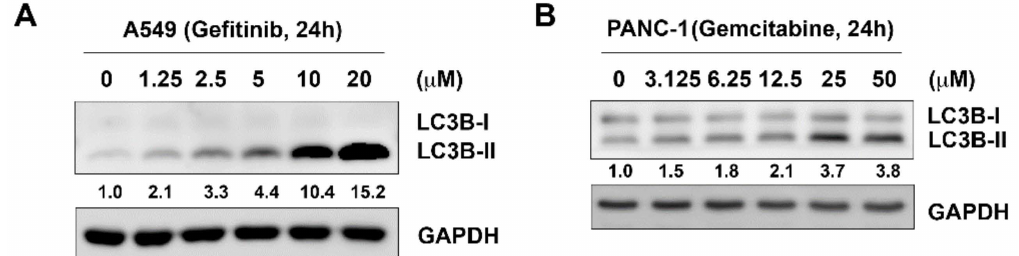
Figure 1. E ff ects of targeted or chemotherapeutic agents on autophagy in cancer cells. ( A ) A549 and ( B ) PANC-1 cells were treated with indicated drugs for 24h and subjected to western blot analysis by antibodies against LC3B and